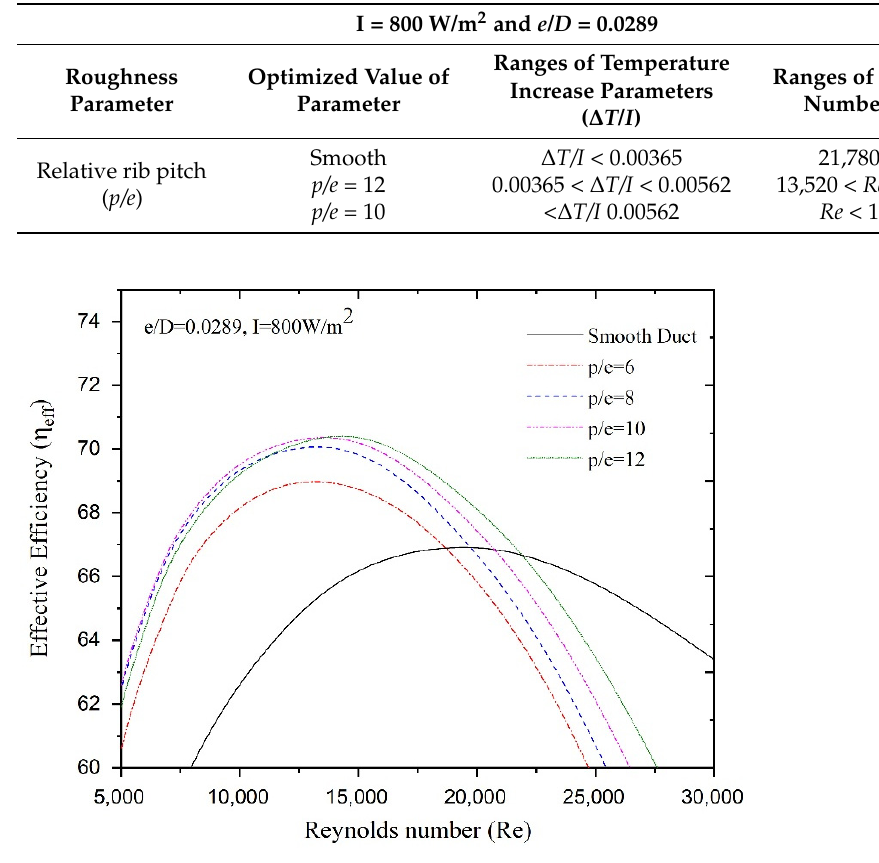
Figure 9. Effect of Reynolds number on effective efficiency. Table 4. Ranges of temperature increase parameters and Reynolds numbers.